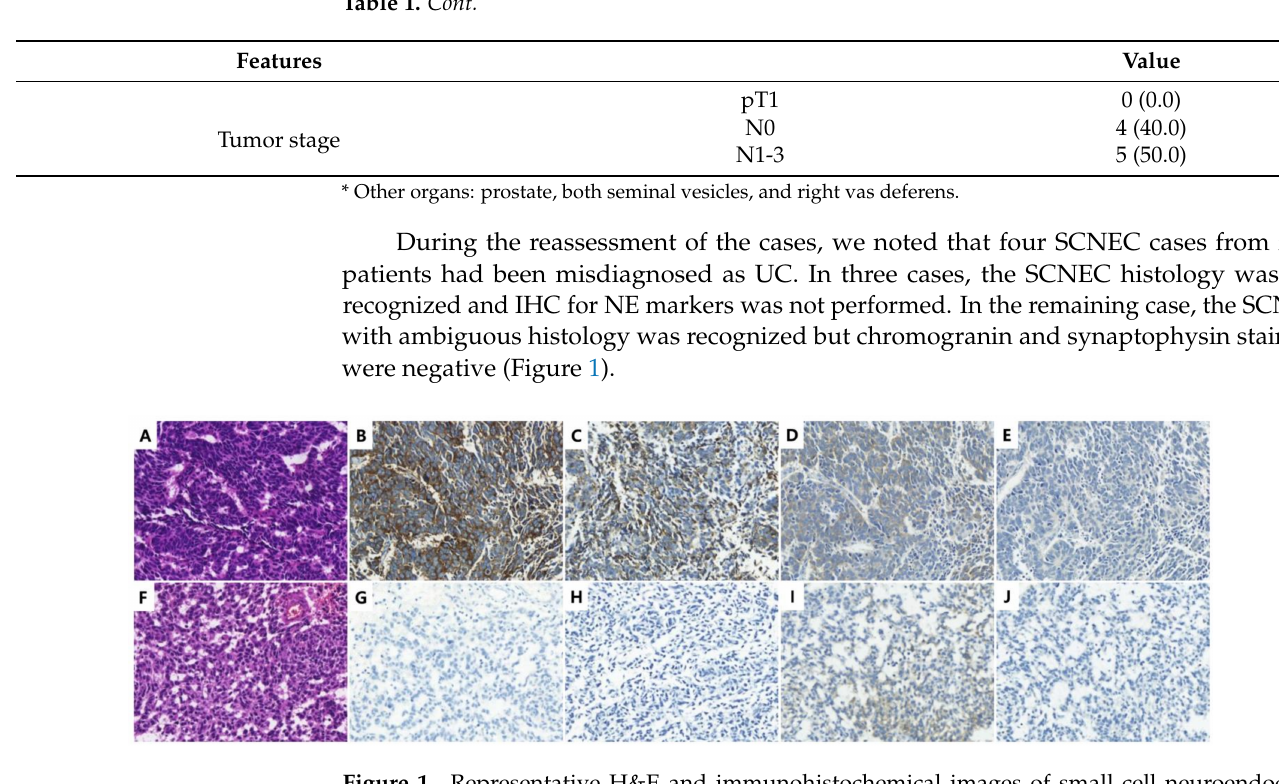
Figure 1. Representative H&E and immunohistochemical images of small cell neuroendocrine carcinoma (SCNEC) of classic histology ( A – E ) and with ambiguous histology ( F – J ). SCNEC shows sheets of relatively small cells with scant cytoplasm, speckled nuclei, and indistinct nucleoli ( A ). It is typically immunoreactive for synaptophysin ( B ), chromogranin ( C ), and CD117 ( D ) and negative for GATA3 ( E ). SCNEC with ambiguous histology shows sheets of cells with small to medium nuclei, relatively abundant cytoplasm, mild pleomorphism and occasional nucleoli ( F ). Although this case is immunonegative for synaptophysin ( G ) and chromogranin ( H ), the tumor is diffusely immunoreactive for CD117 ( I ) and negative for GATA3 ( J ). (Original magnification: A–I, ×